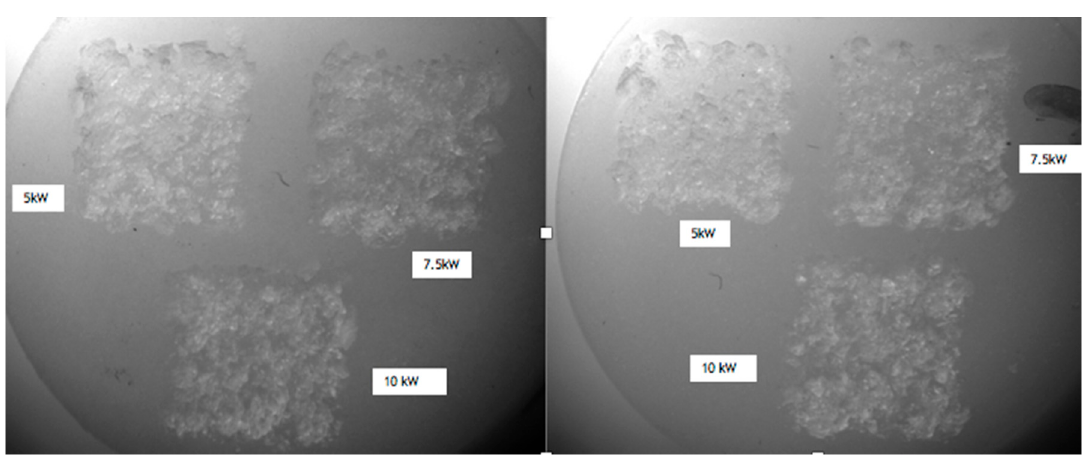
Figure 1. ( Left ) A Group A sample irradiated at 10 mm/s; ( Right ) A Group B sample irradiated at 50 mm/s.